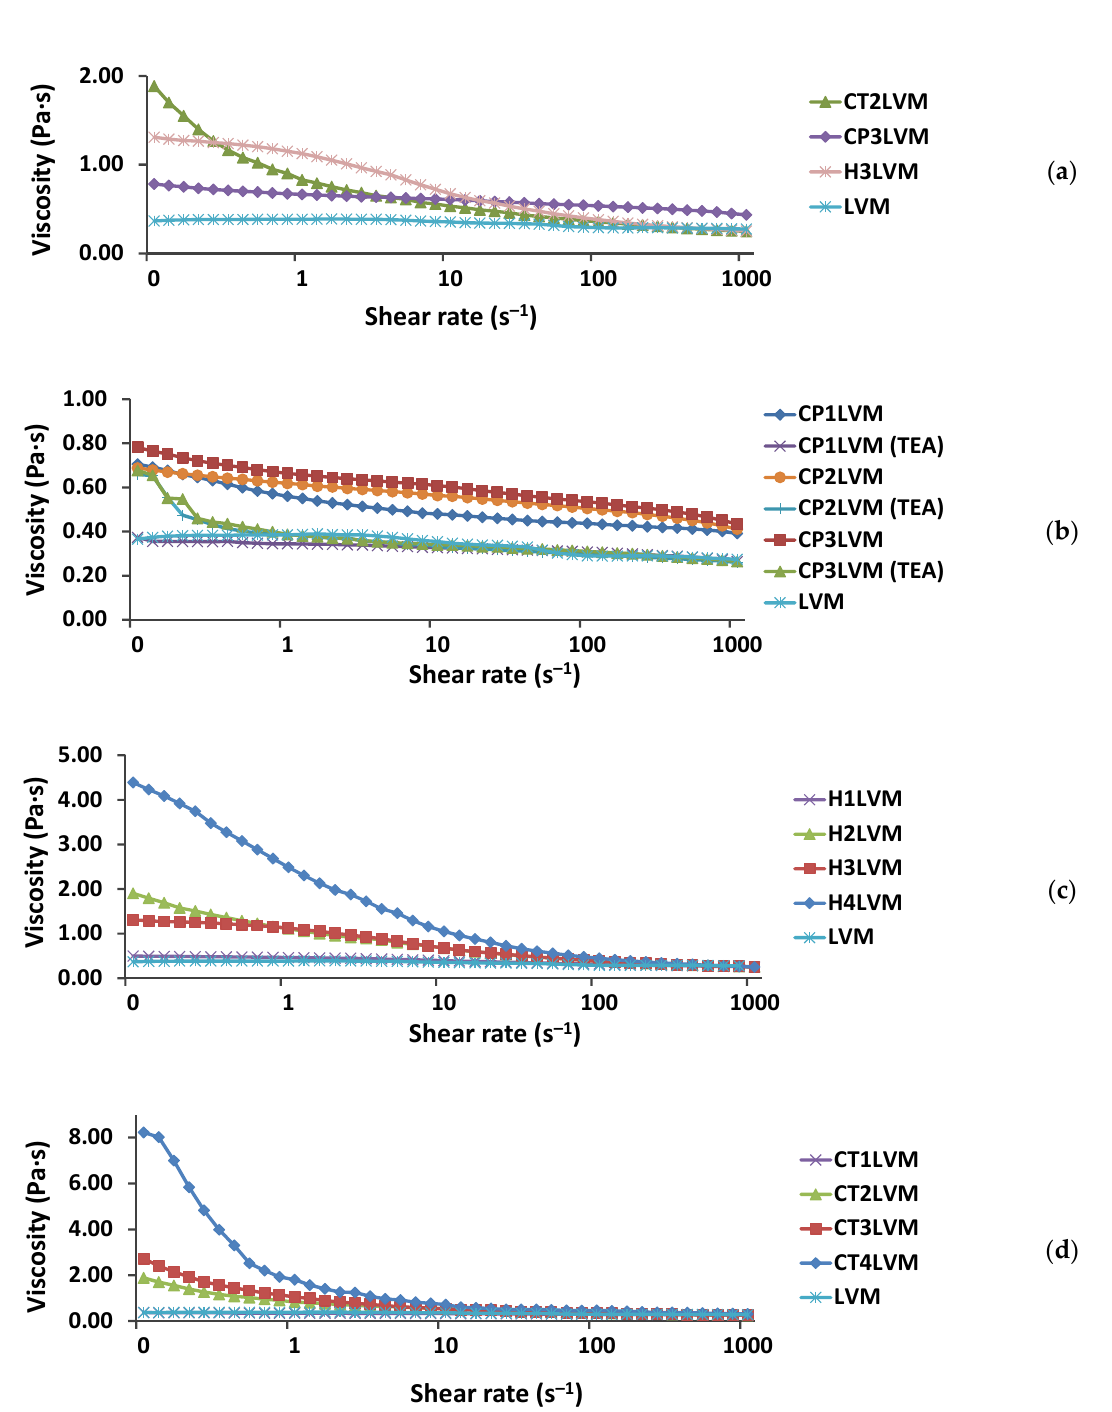
Figure 2. Visual appearance of gel microemulsions used as Curcumin delivery system.